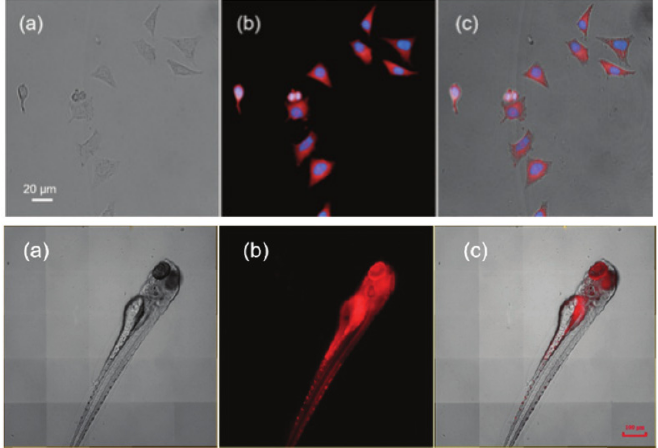
Figure 7. Confocal fluorescence images of HeLa cells and a zebrafish stained with 7a and Hoechst 33342. ( a ) Bright field image, ( b ) fluorescence image, ( c ) merged images. Top : High content screening images of HeLa cells stained with 7a and Hoechst 33342. Red channel: 7a (490–515 nm); blue channel: Hoechst 33342 (350 nm). Bottom : High content screening images of zebrafish stained with 7a. Red channel (490–515 nm). Adapted from [24].